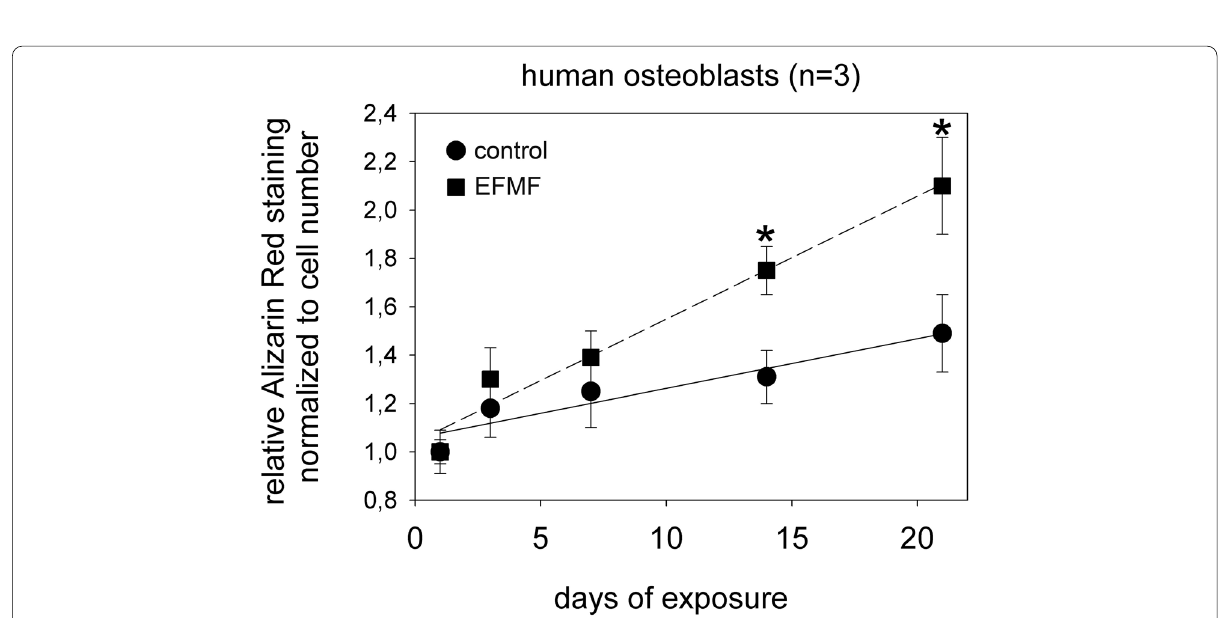
Fig. 5 Alizarin red staining of hOBs after exposure to EFMF. Staining was quantified with an ELISA reader at 405 nm, and the results were normalized to the cell number detected in the exposure wells. n